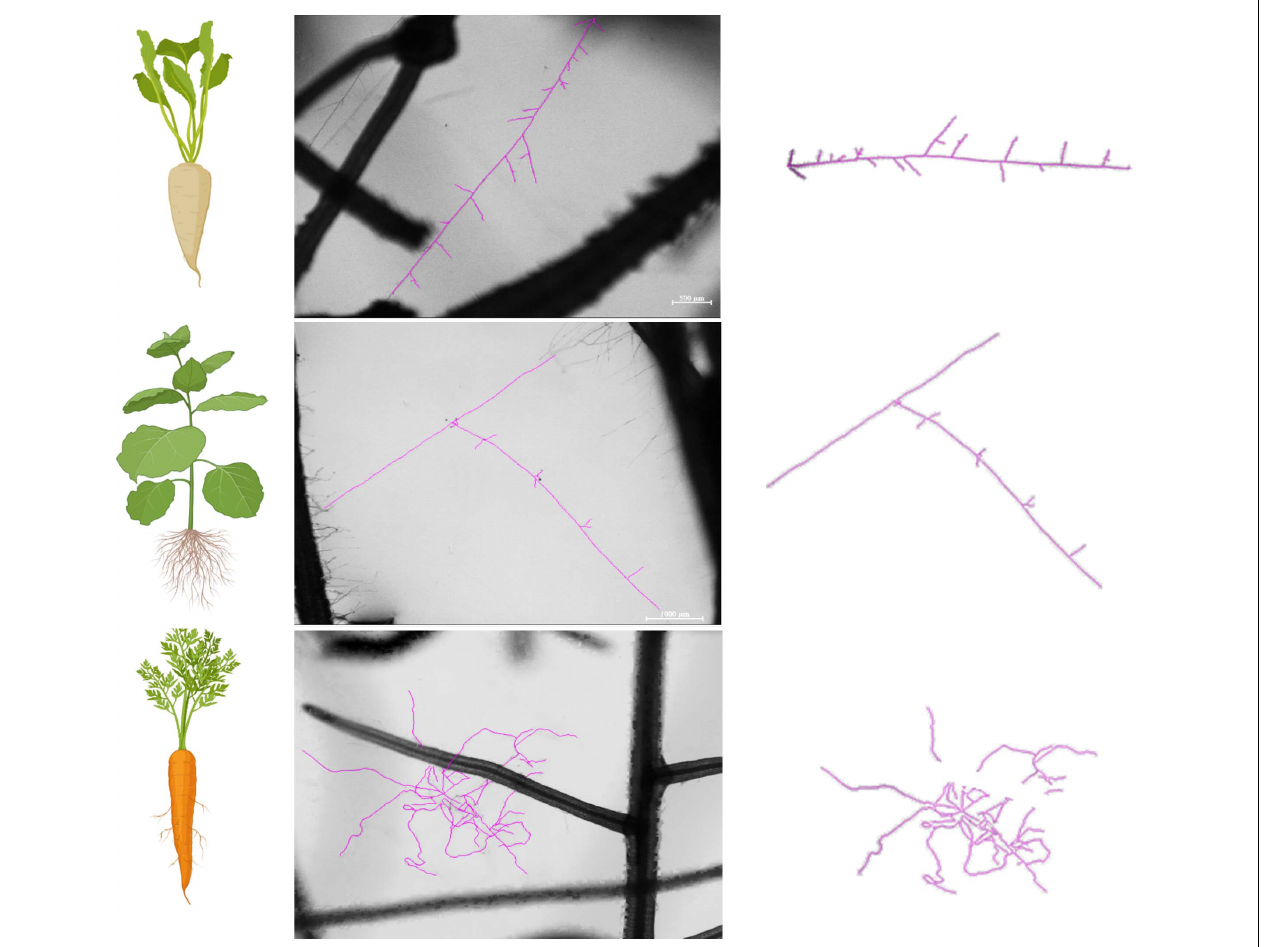
FIGURE 6 | Hyphal growth patterns as affected by the host plant identity. We observed distinct hyphal growth patterns across strains, regardless of their genetic organization (Homokaryons vs. Dikaryons). Specifically, hyphae supported by Cichorium intybus resembled the morphology of a “fish bone” with regular, short-length branching patterns. Hyphae related to Nicotiana benthamiana was the least complex of the three and was mostly linear with limited, irregular, and noticeably short branches. Finally, hyphae supported by Daucus carota exhibited the most complex growth of the three with lengthy and abundant branches and a lot of three-dimensional growth. The observed differences are not due to different developmental stages since the growth patterns remain consistent throughout the hyphal network